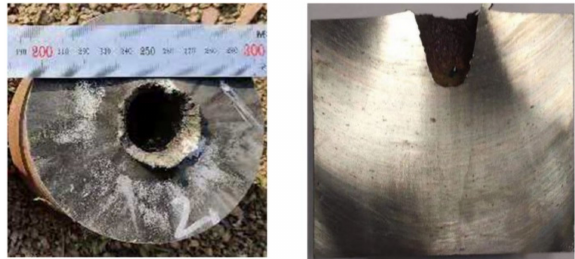
Figure 10. Experimental results of the PTFE / Al reactive jet against the steel target (on the left is the entrance hole view of the steel plates; on the right is the section view of the steel